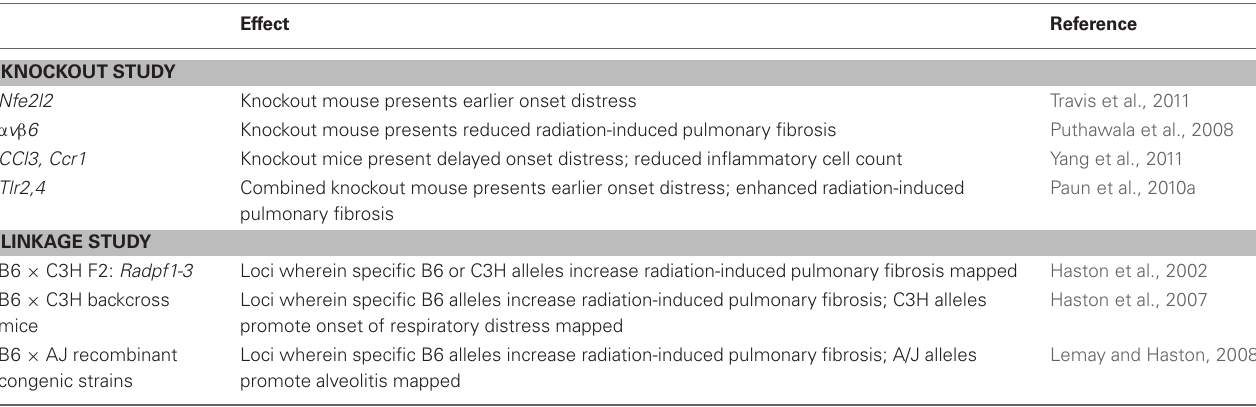
Table 1 | Genetic modifiers of radiation-induced lung